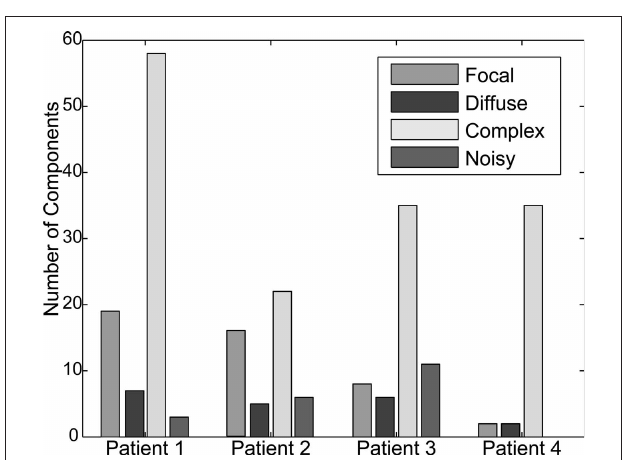
FIGurE 6 | Classes of component maps. Percentage of components for each patient falling into each of the four categories based on visual inspection and manual